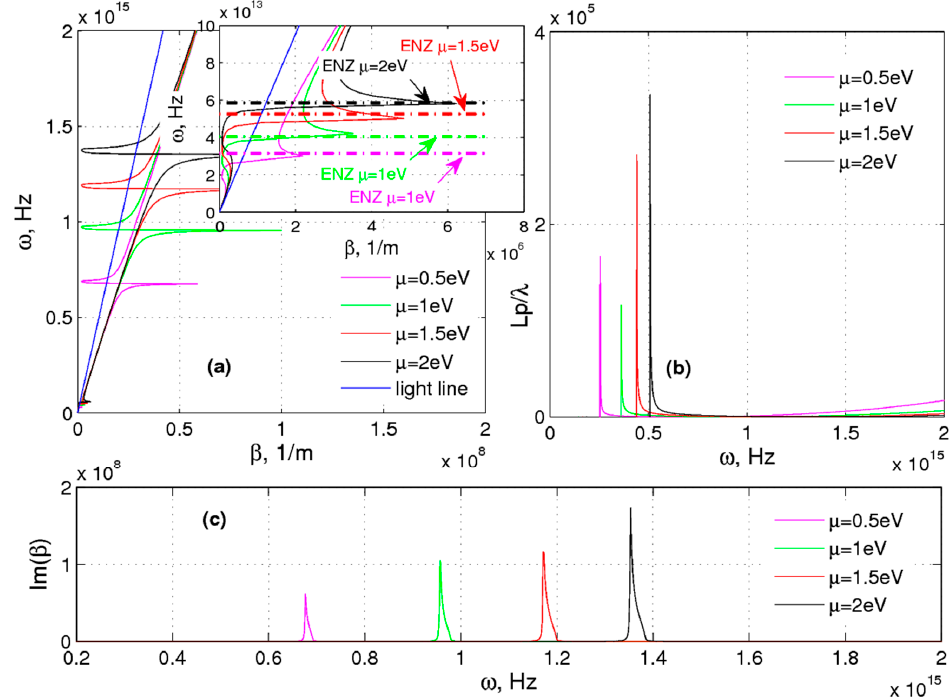
Figure 4. The dispersion of surface plasmonic polaritons (SPPs) ( a ); propagation lengths ( b ) and absorption ( c ) at different Fermi energies, where the number of graphene layers N = 1, d d = 10 nm, ε 1 = ε 3 , ε 2 (cid:54) = ε 4 , and d 1 (cid:54) = d 2 (cid:54) = d 3 (cid:54) = d 4 , and the blue line in ( a ) denotes the free space light